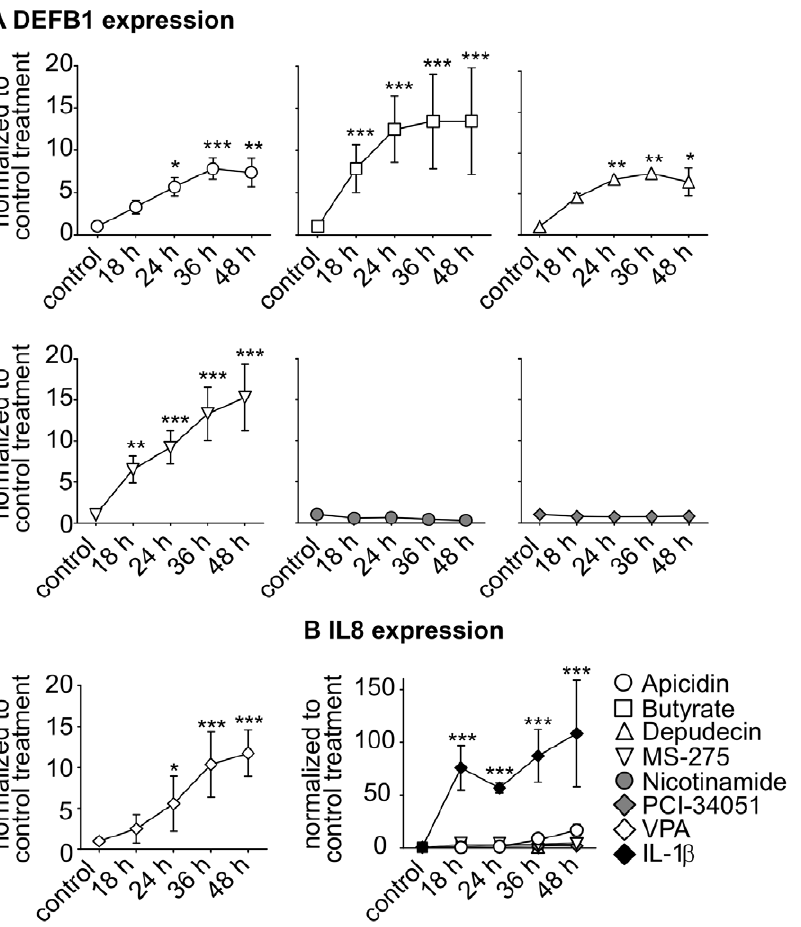
Figure 2. Modulation of DEFB1 gene expression by HDAC inhibitors. The human lung epithelial cell line A549 was treated with HDAC inhibitors and IL-1 b for 18 to 48 h. mRNA expression of DEFB1 (A) and IL8 (B) was analyzed using quantitative Real-Time-PCR. The measured levels of mRNA were normalized to TBP mRNA levels. DEFB1/IL-8 mRNA expression was normalized to control treatment. Bars represent means with SD of three independent experiments (*: p , 0.05; **: p , 0.01; ***: p , 0.001).